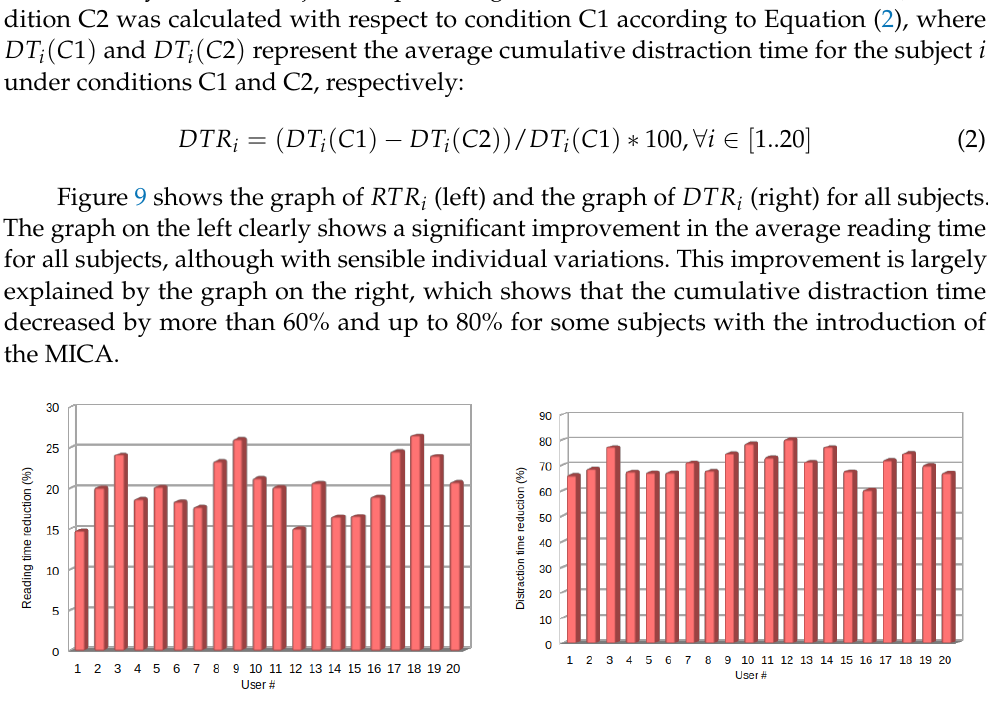
Figure 9. Plots of the percentage reduction in reading time (on the left ) and percentage reduction in cumulative distraction time (on the right ) for each subject, averaged over the six excerpts (see text).